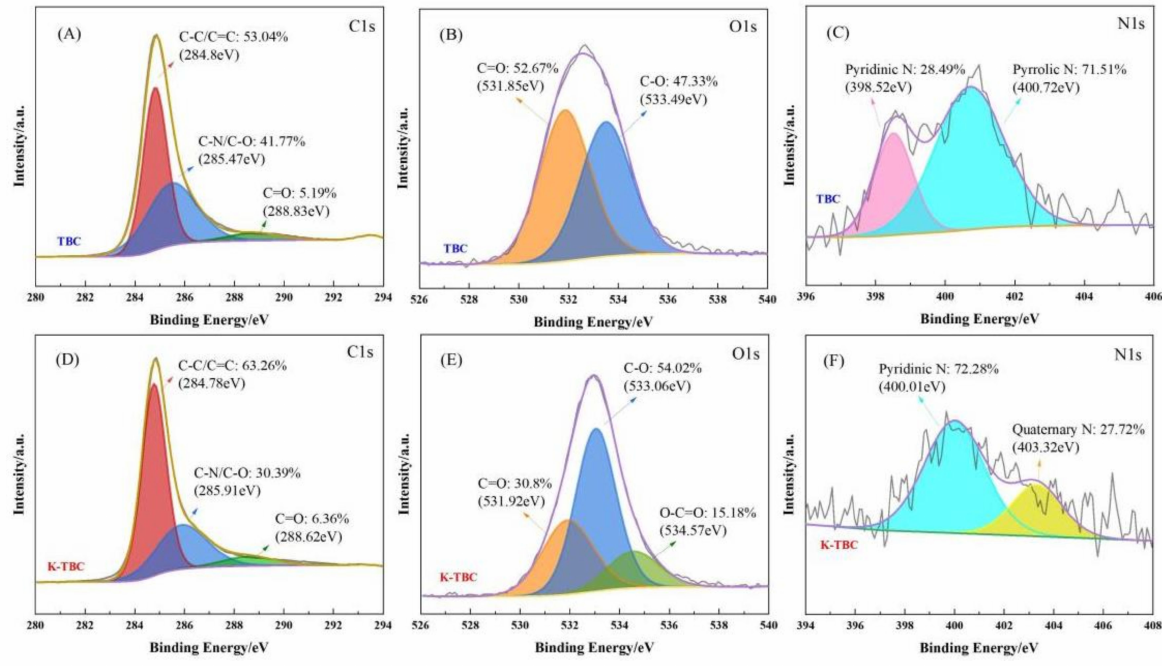
Figure 4. XPS survey spectra of C1s (( A ) TBC and ( D ) K-TBC), O1s (( B ) TBC and ( E ) K-TBC) and N1s (( C ) TBC and ( F )